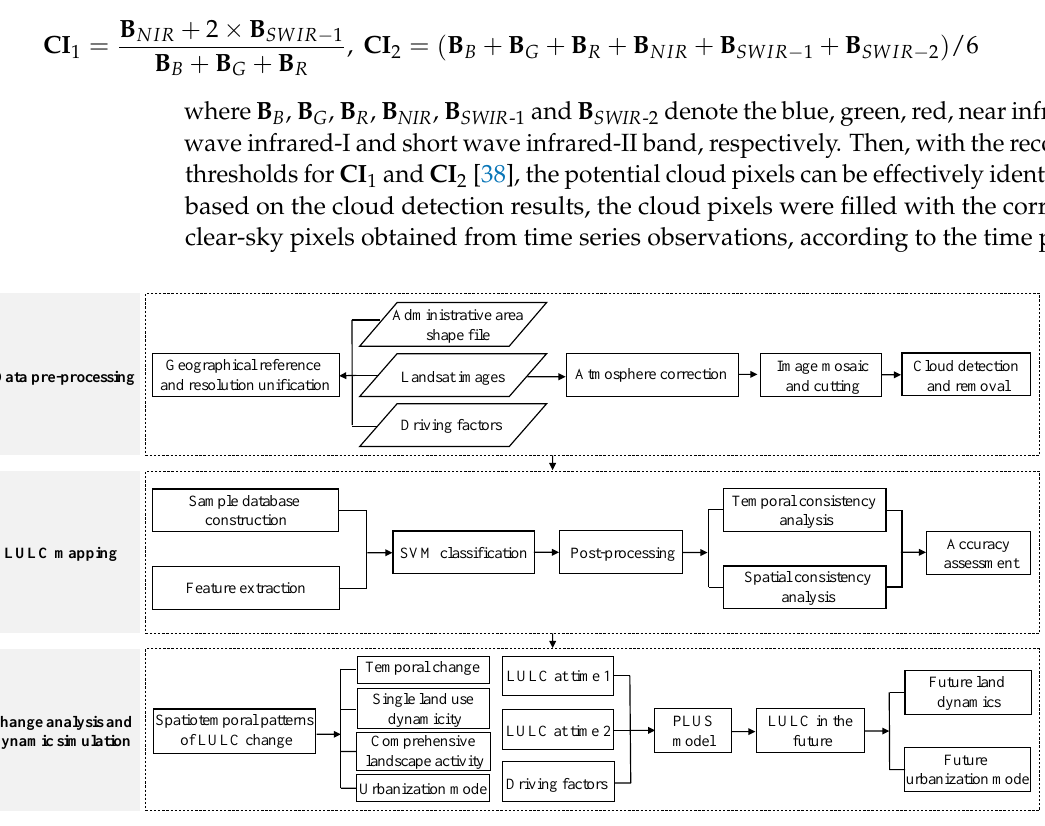
Figure 2. The workflow of this study.